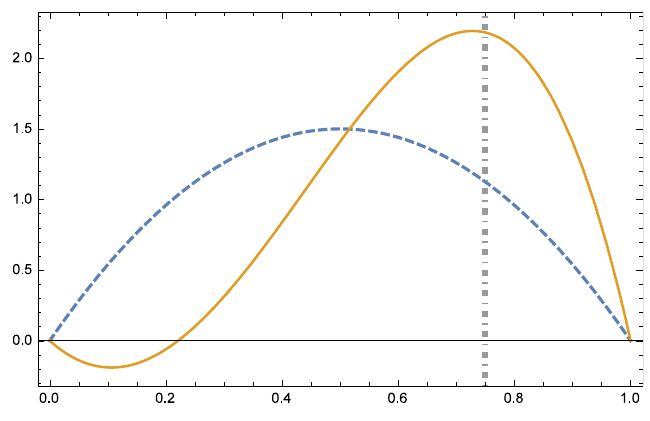
q 2 is deduced by potential model as given h i P x ), while the dot-dashed −